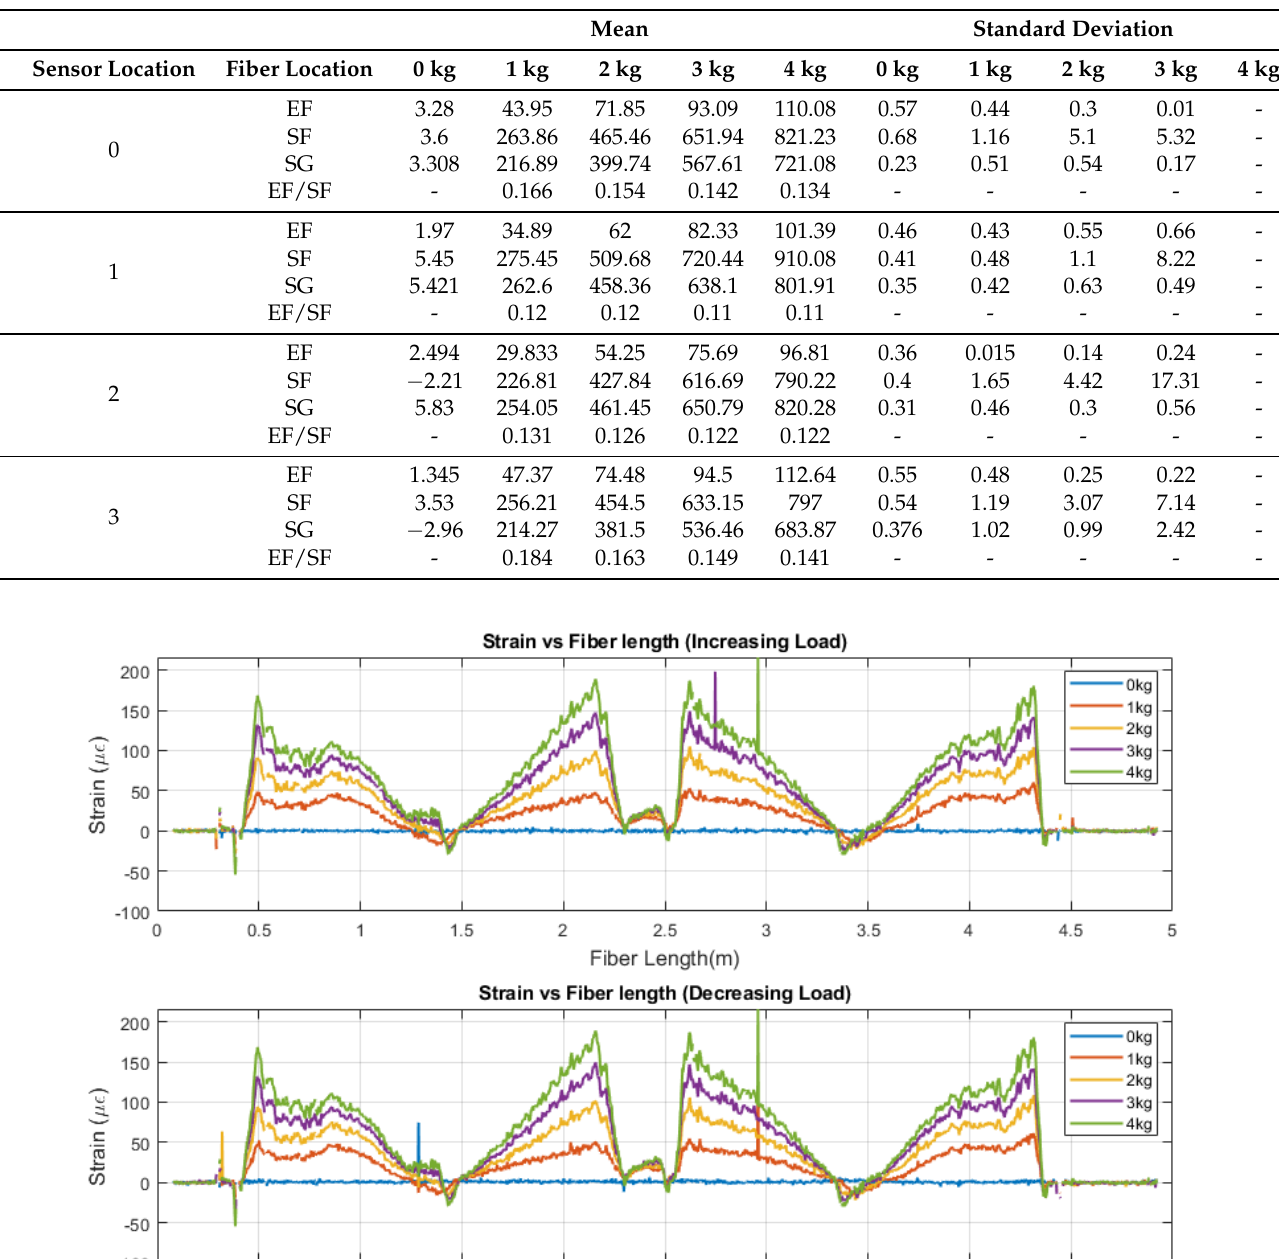
Table 1. Mean and standard deviation at each strain gauge location.